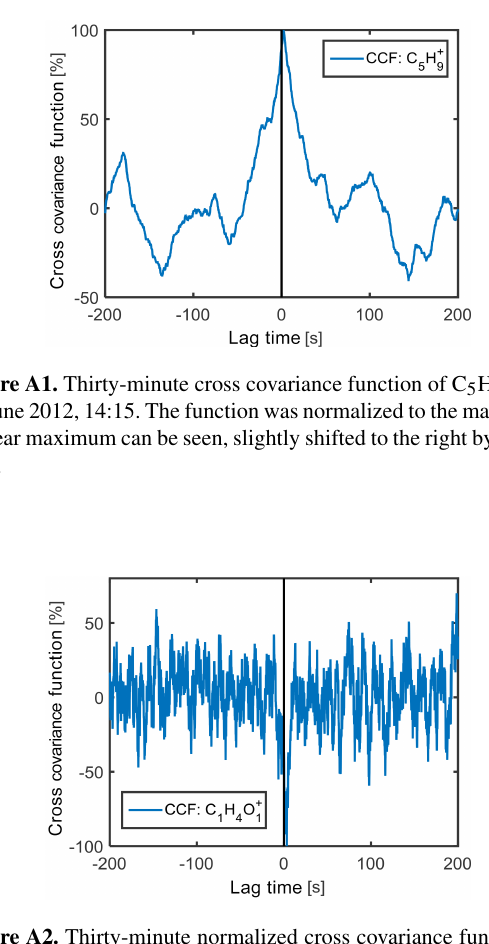
Figure A2. Thirty-minute normalized cross covariance function of C 1 H 4 O + from 22 June 2012, 04:45. A clear minima can be seen, 1 which defines downward fluxes.